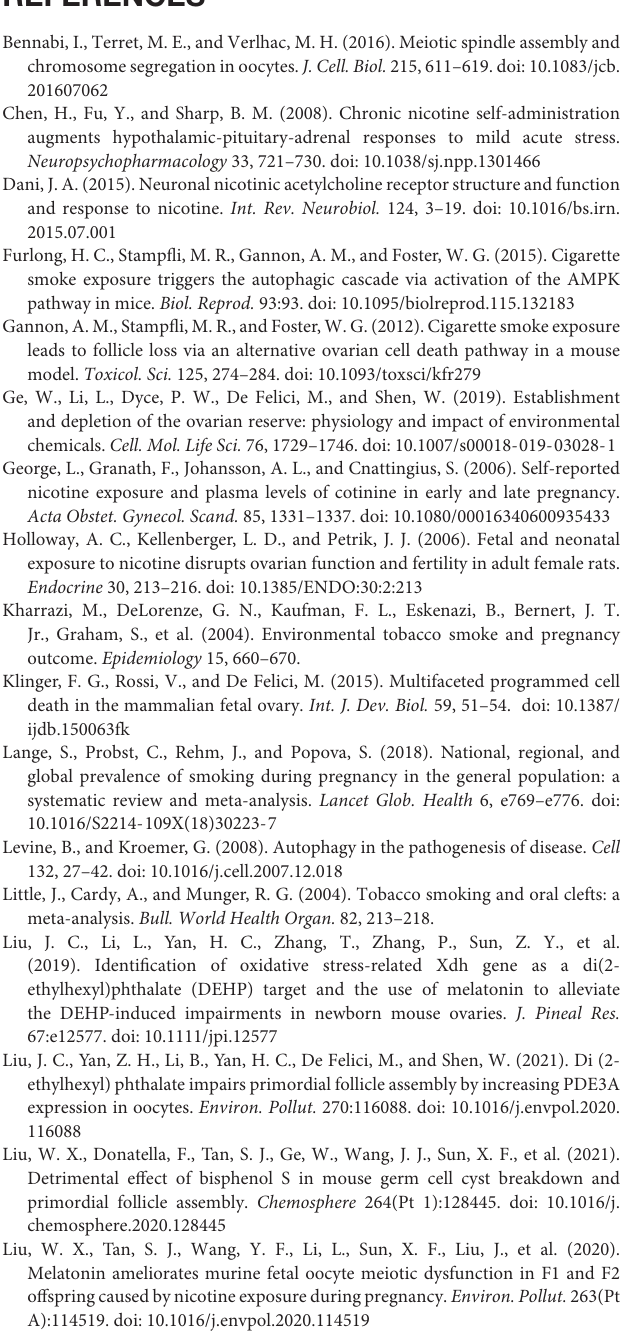
protein level of LHR in the control and LH groups. (F) Relative changes of Fshr in the mRNA expression of mice treated with FSH for 4 days. (G) Representative image of IF for the FSHR in tissue sections of ovaries in the control and FSH groups. (H) Relative protein level of FSHR in the control and FSH groups. The data are presented as means ± S.E. of three independent experiments (each in triplicate). ∗ P < 0.05, ∗∗ P < 0.01, and ns P > 0.05. Supplementary Figure 5 | An analysis of folliculogenesis of 21-day ovaries after intraperitoneal injection for 4 days in each treatment group. (A) Representative IHC